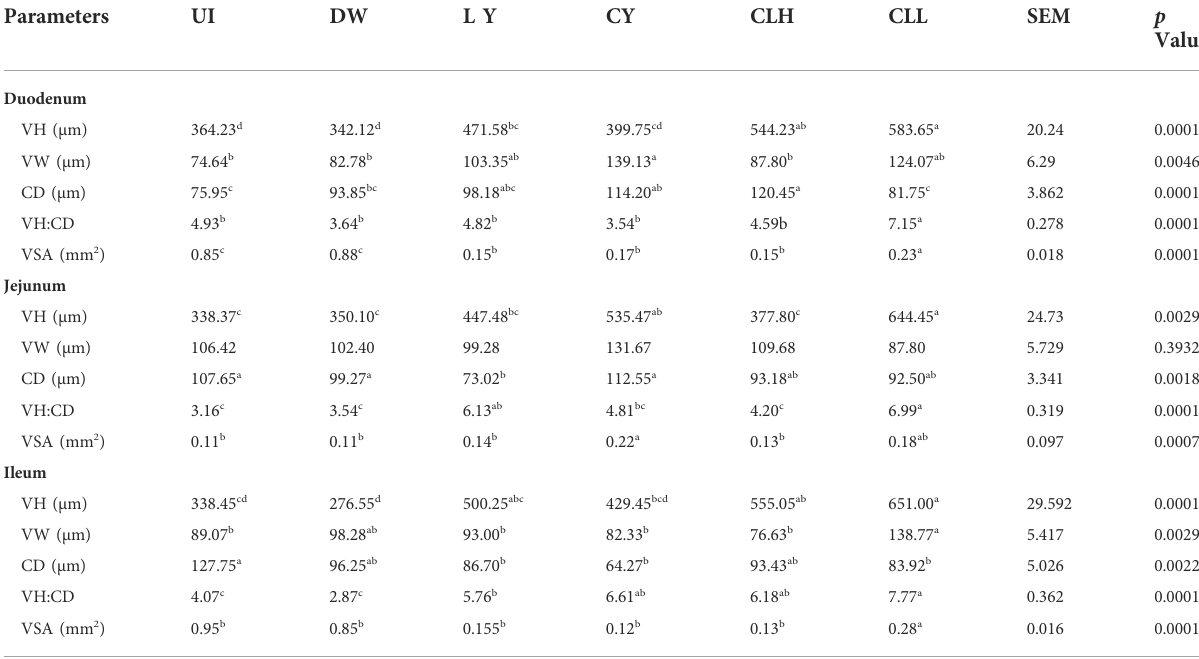
TABLE 6 In fl uence of in ovo cysteine and lysine on performance broiler chickens. Parameters